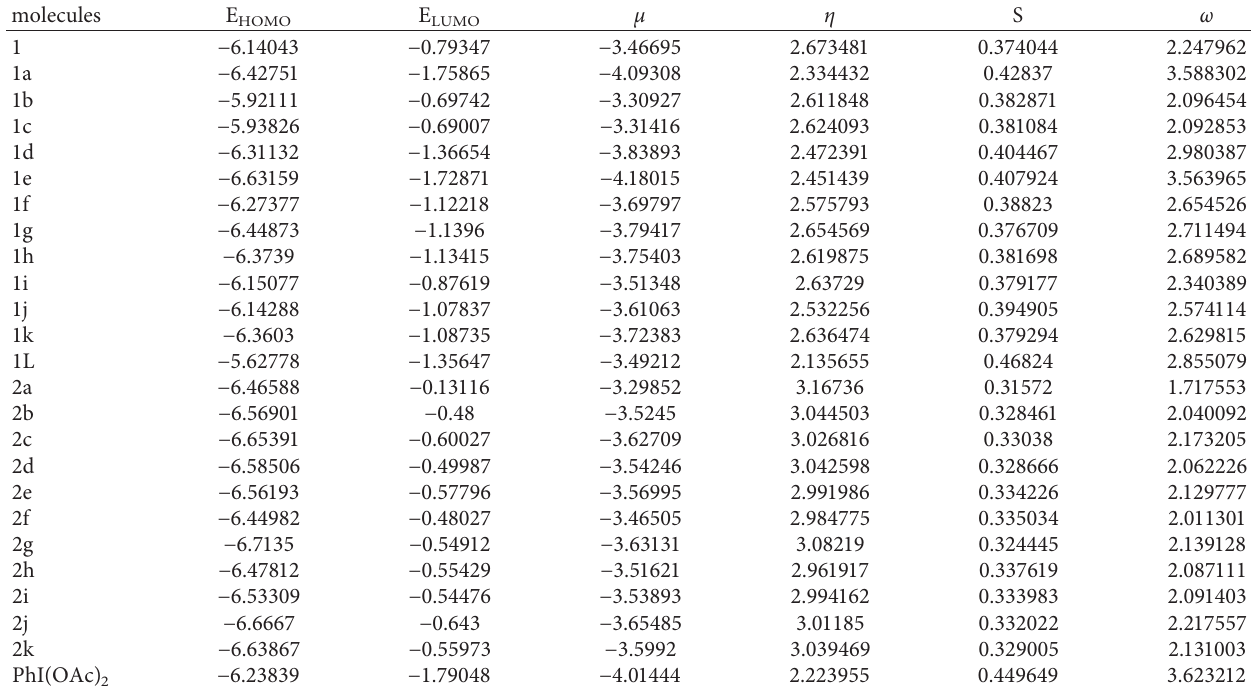
Table 2: HOMO (E HOMO ) and LUMO (E LUMO ) energies, and quantum molecular descriptors, all in eV, for styrene derivatives (1a–1l) and aldehyde radicals(2a–2k) and PhI(OAc) 2 .